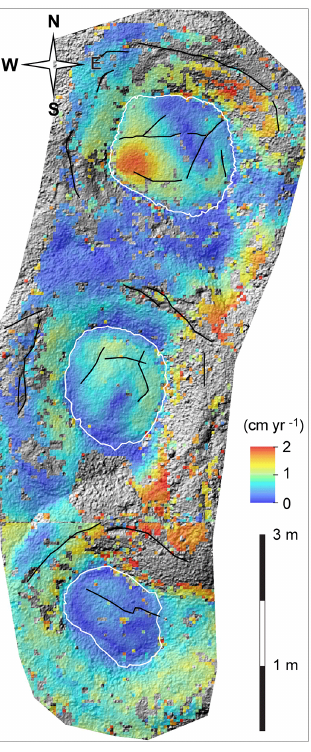
Figure A2. Displacement magnitude 2007–2010 on all three cir- cles. Erratic displacements have been filtered out following Heid and Kääb (2012). Background: hillshade of 2007. See Supplement for animated GIFs of the 2007 and 2010 orthoimages.